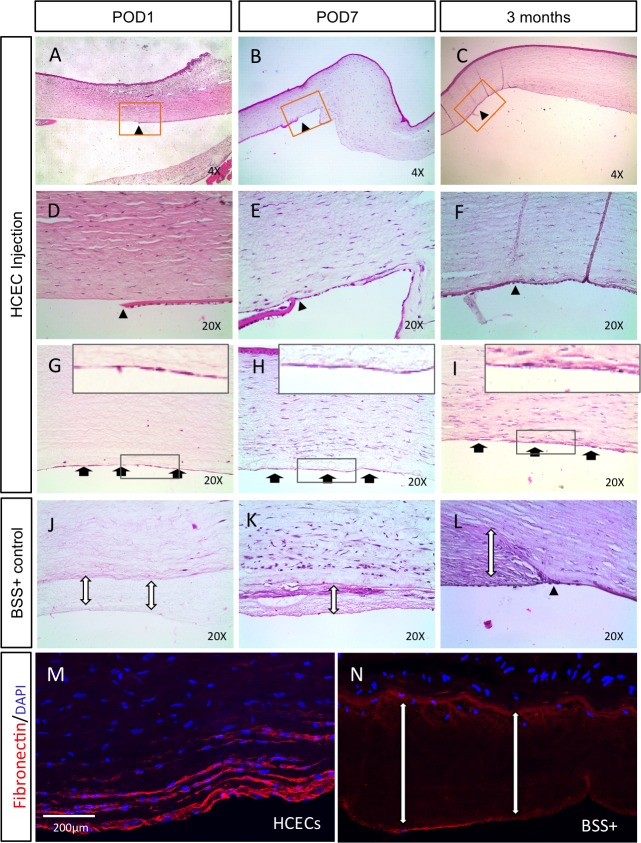
Reconstruction of debrided corneas with HCECs. After DM stripping and injection of HCECs, the edges of the injury can be observed in histologic sections acutely (A, D; arrowheads), after one week (B, E; arrowheads) or 3 months (C, F; arrowheads). A thin monolayer with flat nuclei, with characteristics similar to normal human endothelium, was observed on rabbit stroma in the central stripping area (G–I, black arrows). In the control eyes, there is a thick fibrin layer on the posterior cornea (J–L, double-headed arrows) and the stroma is edematous. Fibronectin immunostaining in an experimental (M) and control (N, double-headed arrows) eye was observed after 3 months. The corneal structure became deformed (L, double-headed arrow), while a more compact stroma was observed after HCEC injections (H, I, M).